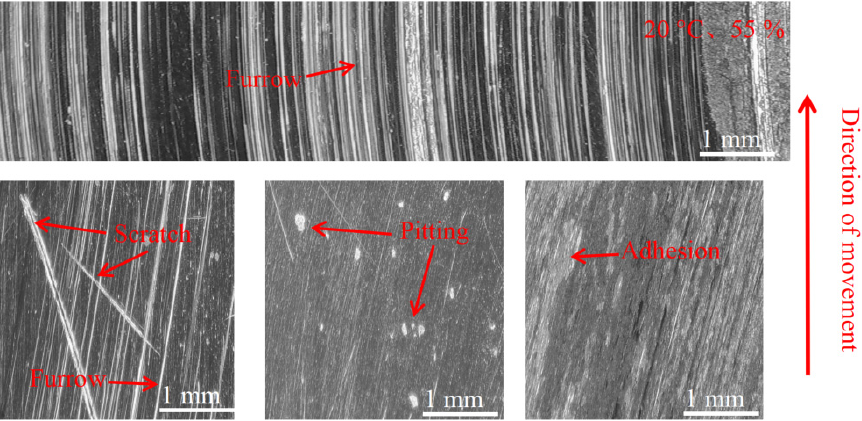
◦ C and 55% ambient humidity.